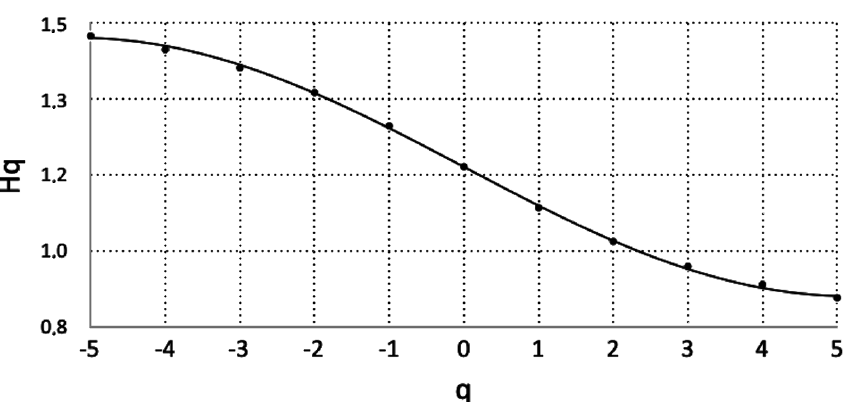
Figure 2. Generalised Hurst exponent ( h ( q ) ) versus q s for the AGP monitoring station and date 28 July 2007 (case i/i = 2 of Table